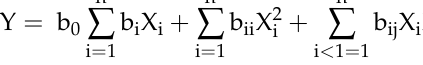
Table 1. Parameters and levels for the optimal design. Independent Variables Factor X i Range and Level − 1 0 +1 Applied potential (kV) X 1 12 14 16 Distance (cm) X 2 8 10 12 Calcination temperature ( ◦ C) X 3 600 700